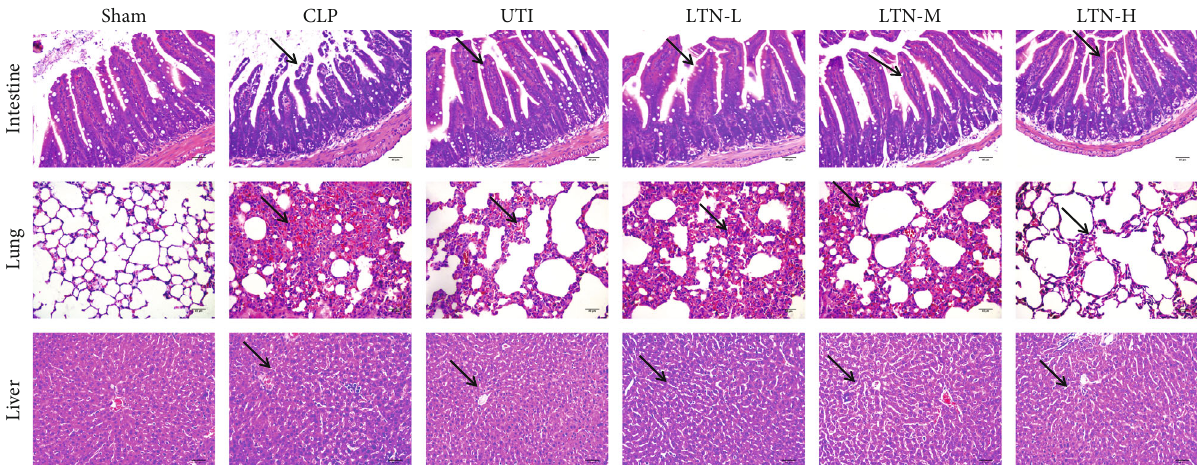
Figure 1: Lentinan alleviates injuries of the intestine, liver, and lung in mice with gut-origin sepsis. CLP: cecal ligation and perforation; UTI: ulinastatin; LTN-L: 5 mg/kg lentinan; LTN-M: 10mg/kg lentinan; LTN-H: 20mg/kg